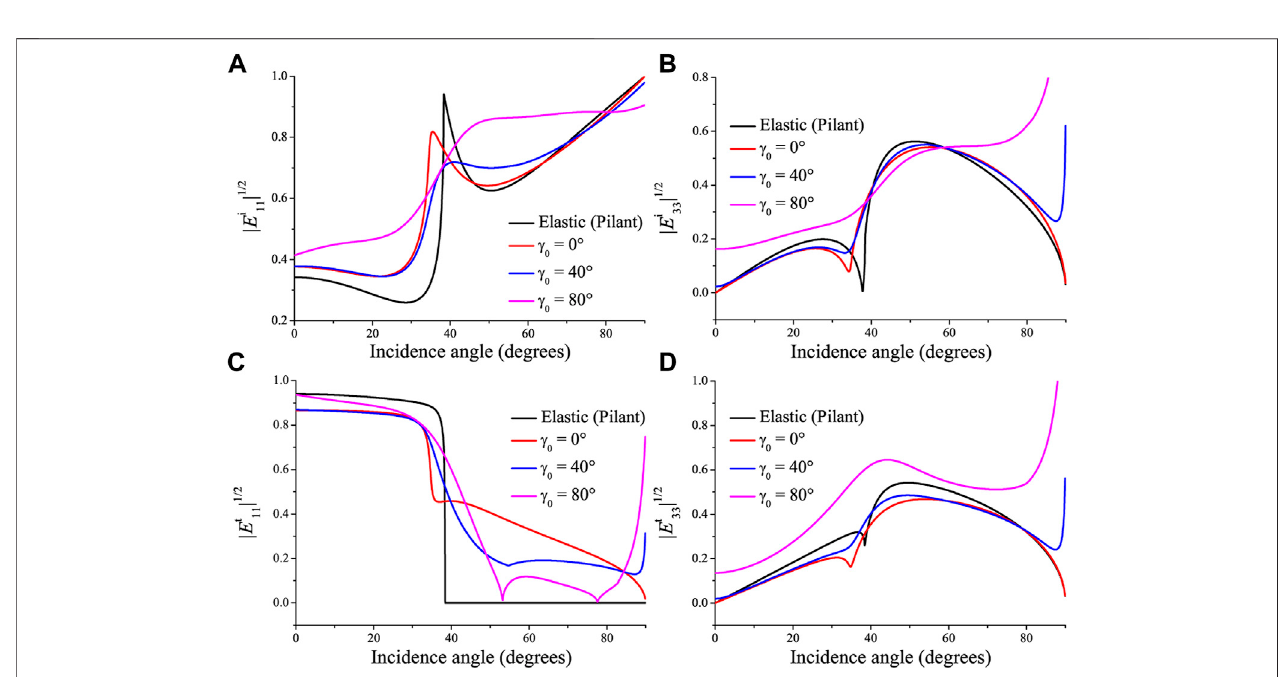
FIGURE 6 | Same as Figure 4 but for the square root of the energy ratios of the re fl ected P (A) , re fl ected S (B) , transmitted P (C) and transmitted S (D) waves, considering the fl ux in the z -direction.